Question: Condense the content of this figure into a single sentence.
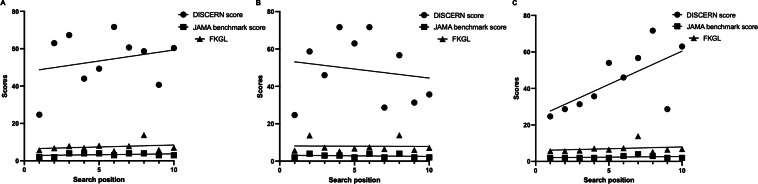
Answer: Scatterplots and best-fit lines of DISCERN, Journal of the American Medical Association (JAMA) benchmark, and Flesch-Kincaid Grade Level (FKGL) scores for Google, Yahoo, and Bing, based on the websites’ positions in the top 10 search engine results. (A) scatterplot of correlation of DISCERN (slope: +1.175; P =.53), JAMA benchmark (slope: +0.091; P >.99), and FKGL (slope: +0.208; P =.59) scores and search position on Google, (B) scatterplot of correlation of DISCERN (slope: −0.996; P =.65), JAMA benchmark (slope: −0.061; P =.58), and FKGL scores (slope: −0.027; P =.94) and search position on Yahoo, and (C) scatterplot of correlation of DISCERN (slope: +3.65; P =.04), JAMA benchmark (slope: +0.073; P =.38), and FKGL scores (slope: +0.198; P =.50) and search position on Bing. Associated slopes and P value representing significance from nonzero slope are represented in tables.